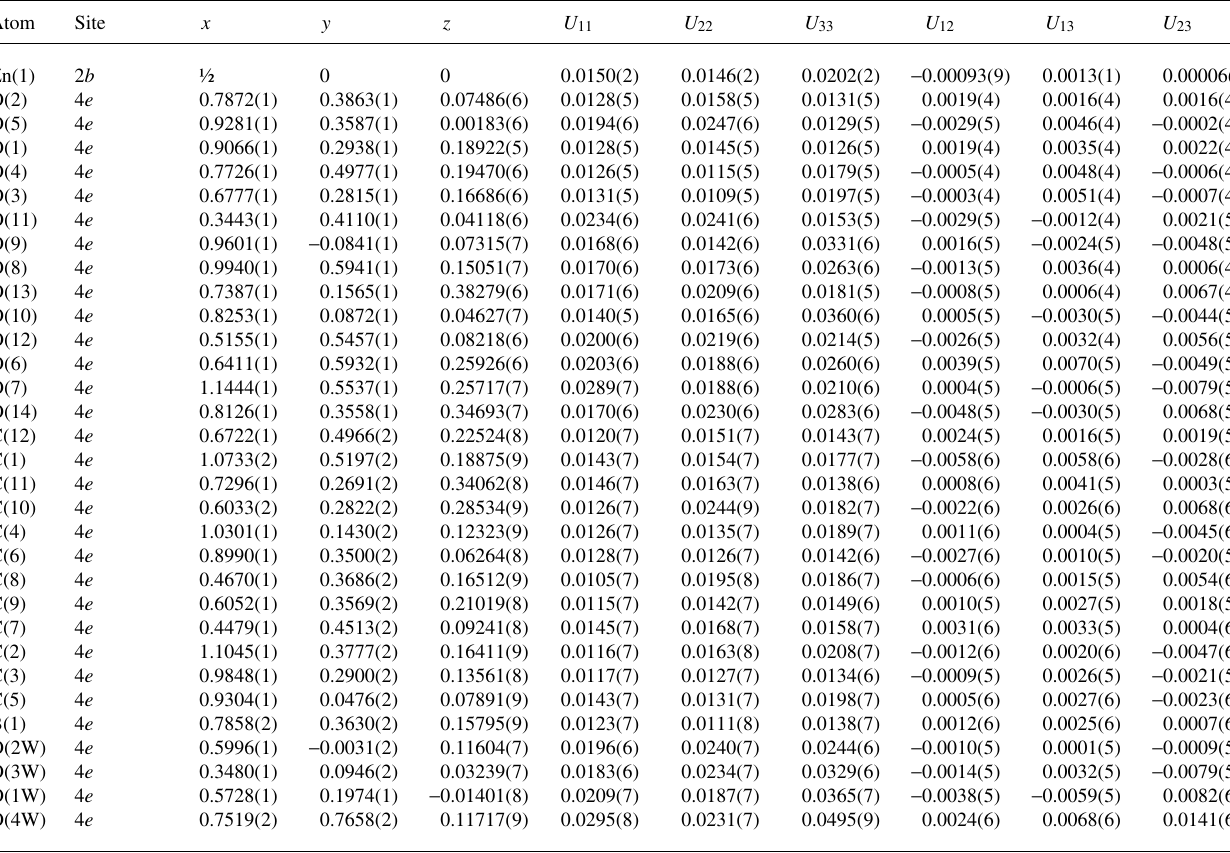
Table 3. Atomic coordinates and displacement parameters (in Å 2 )